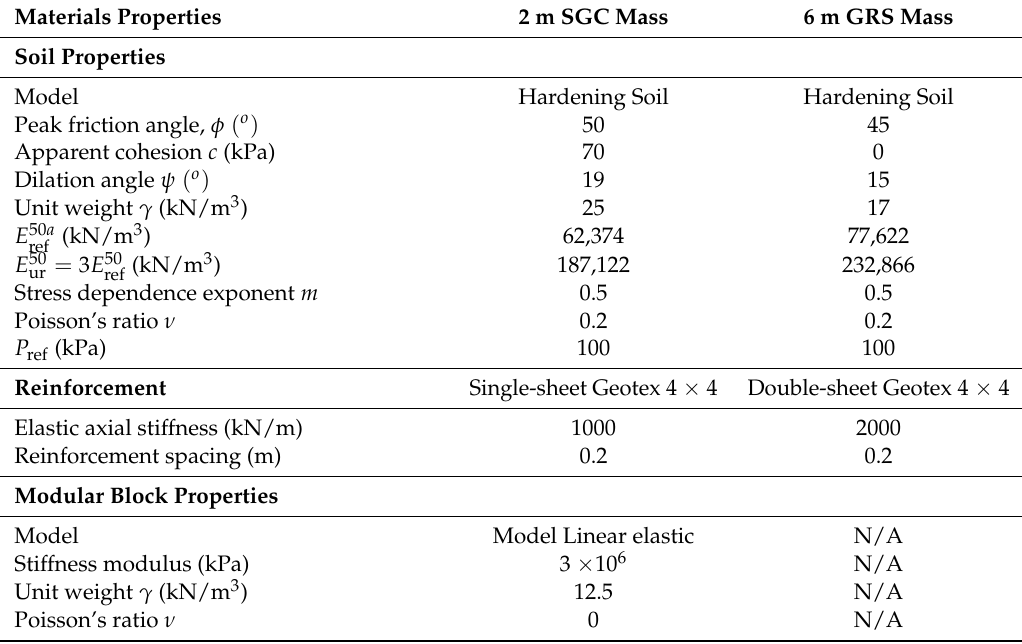
Table 3. Input parameters for finite element